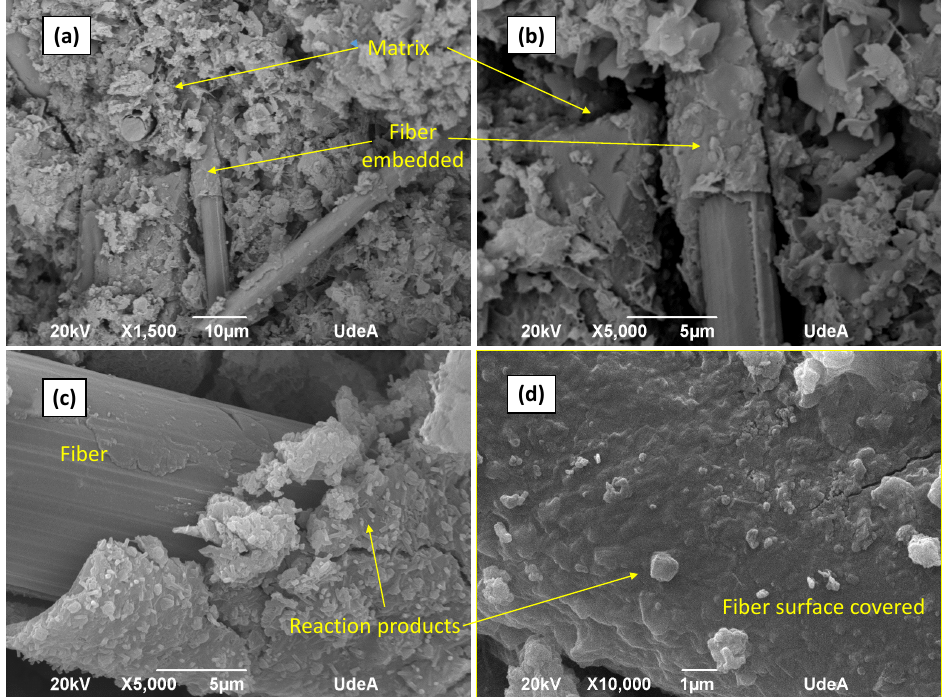
Figure 13. SEM images of alkali-activated cement combinations using Activator 2; ( a ) and